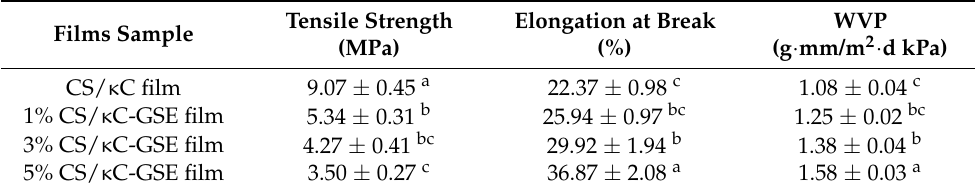
Table 1. Physical properties of CS/ κ C-GSE films with a different concentration of